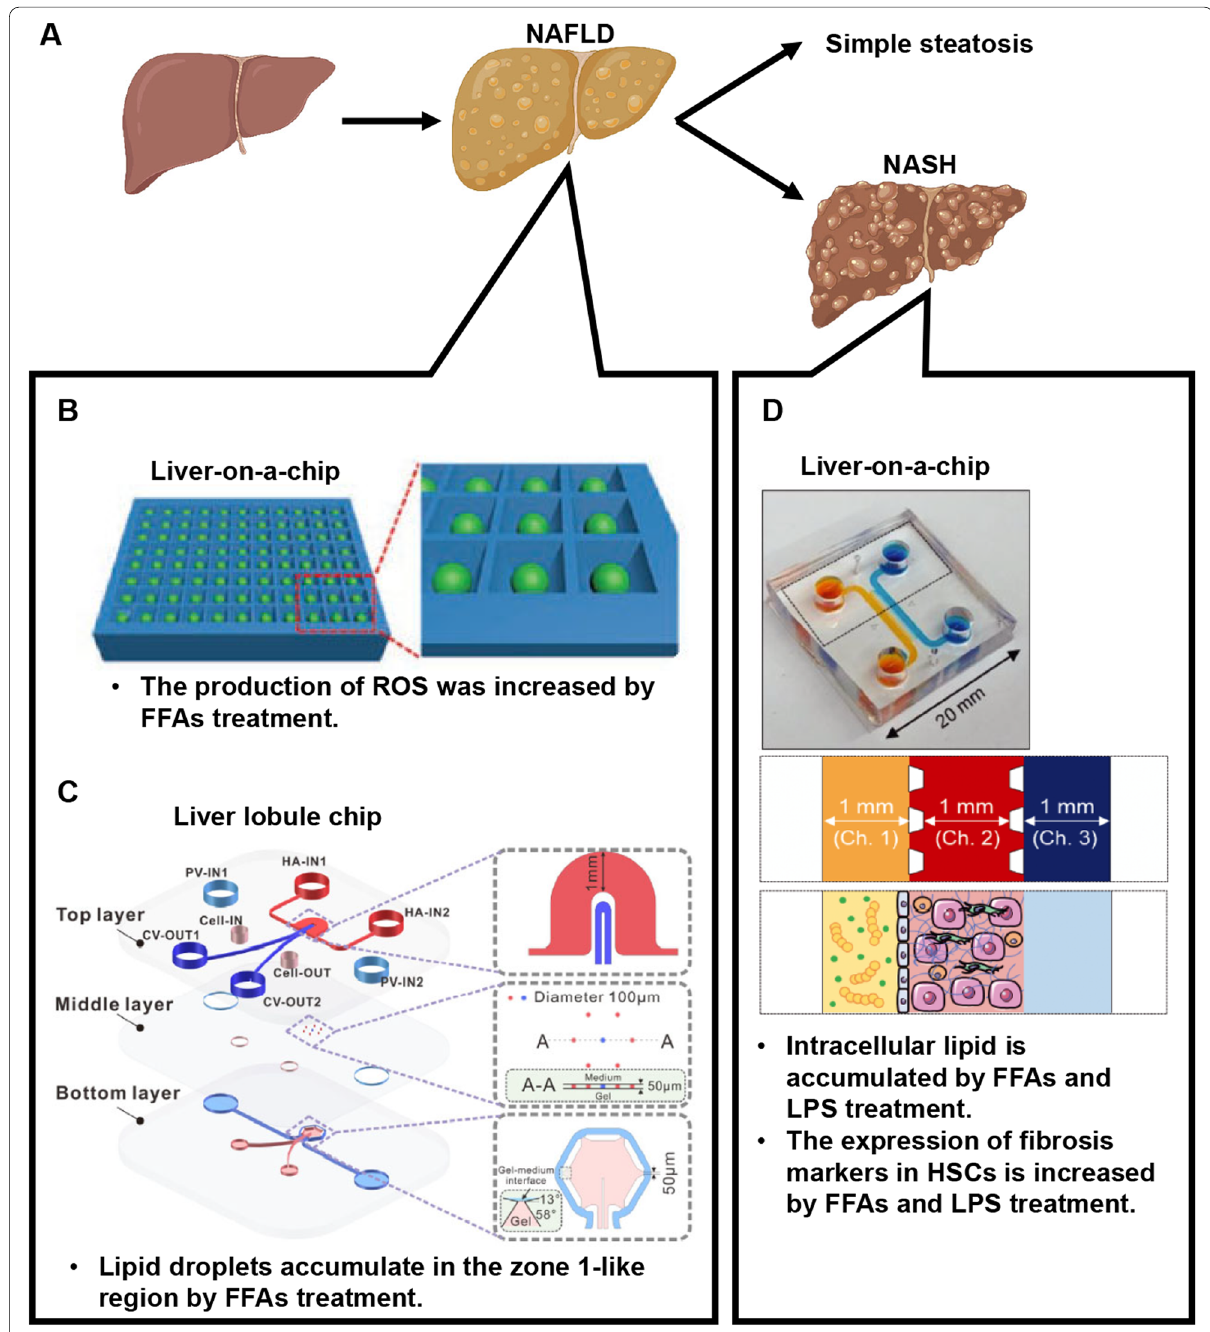
Fig. 4 Study of non-alcoholic fatty liver disease/non-alcoholic steatohepatitis using liver-on-a-chip. A A schematic image of the progression of NAFLD/NASH. Created with Biore nder. com. B , C To recapitulate liver steatosis observed in patients with NAFLD, a liver-on-a-chip ( B ) and liver lobule chip ( C ) were developed. Reprinted with permission from ref [38]. Copyright 2020 John Wiley and Sons. Reprinted with permission from ref [39]. Copyright 2021 Elsevier. D To recapitulate liver fibrosis observed in patients with NASH, a liver-on-a-chip was developed. Reprinted with permission from ref [40]. Copyright 2020 John Wiley and